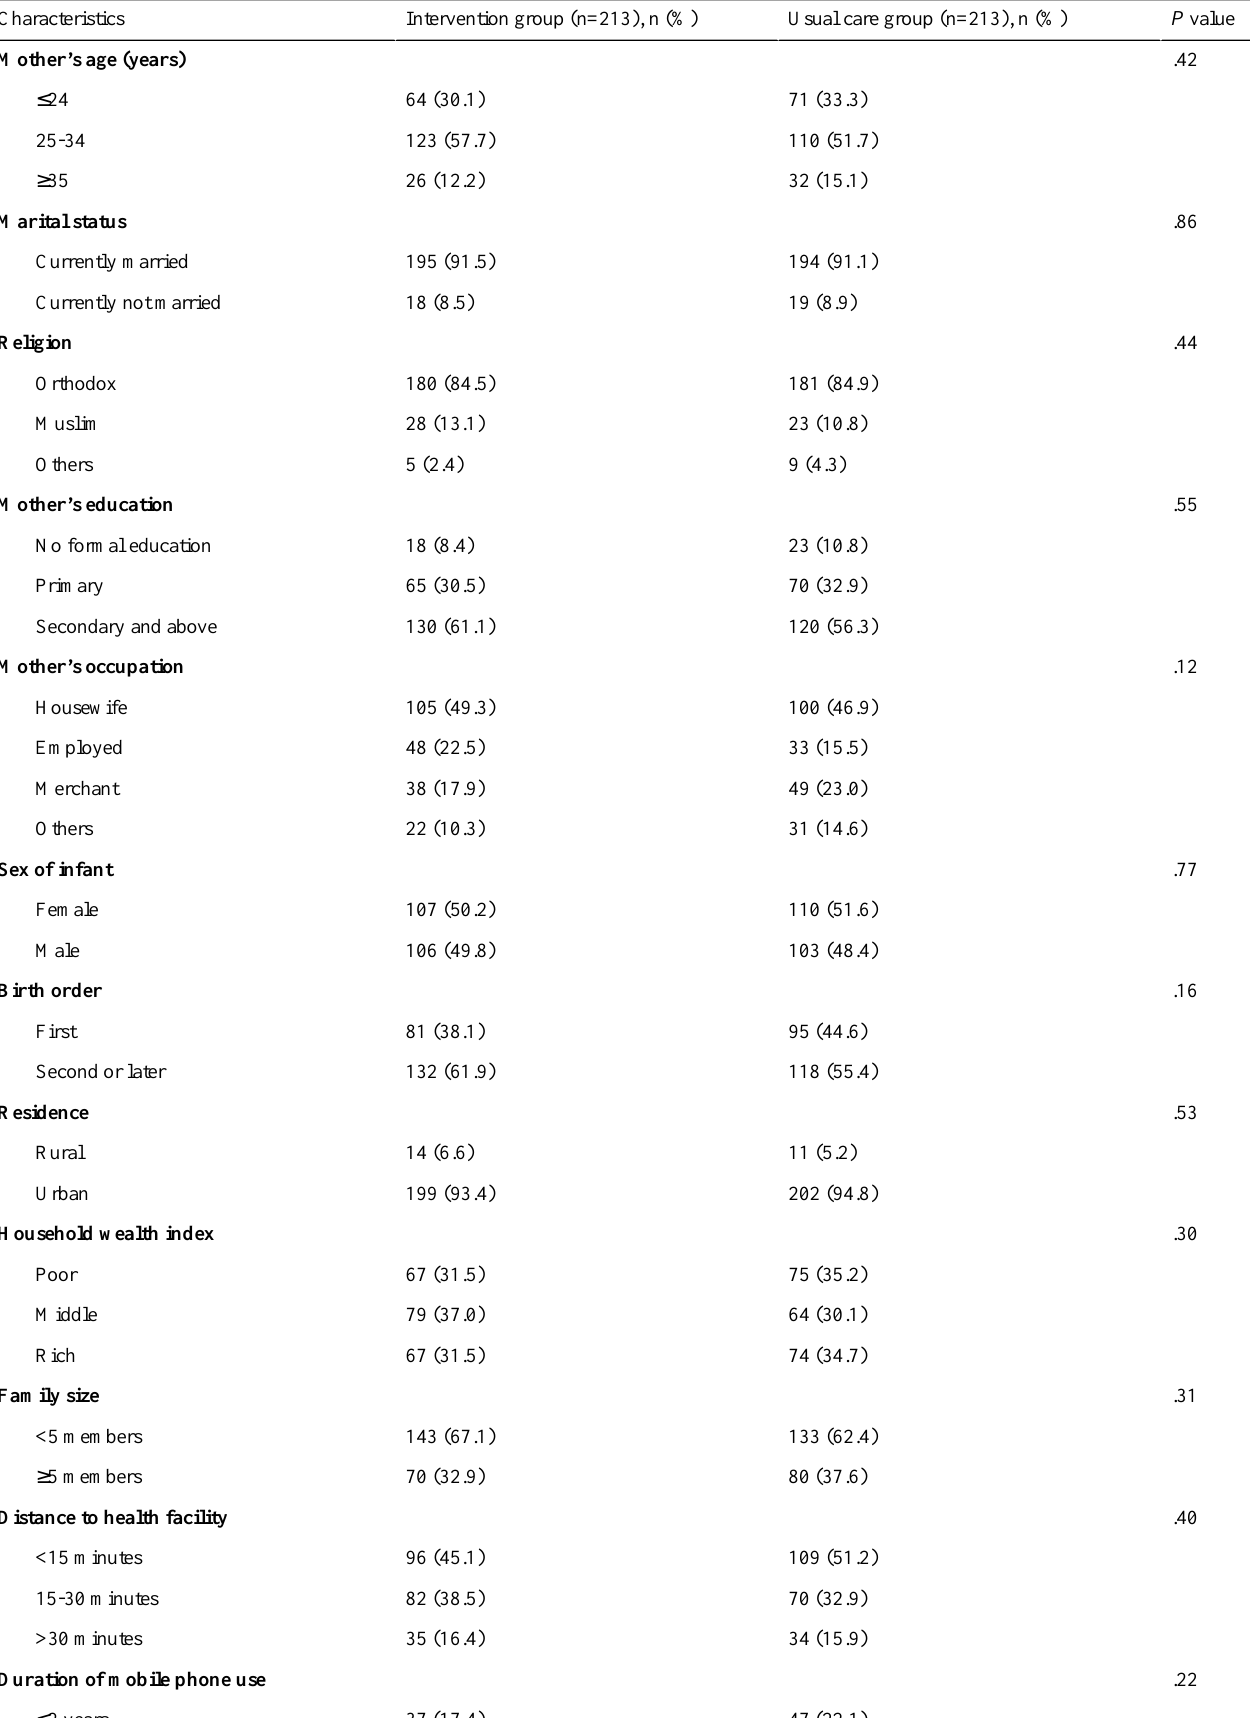
Table 1. Baseline characteristics of the study participants enrolled in the trial in Gondar city, northwest Ethiopia in 2020